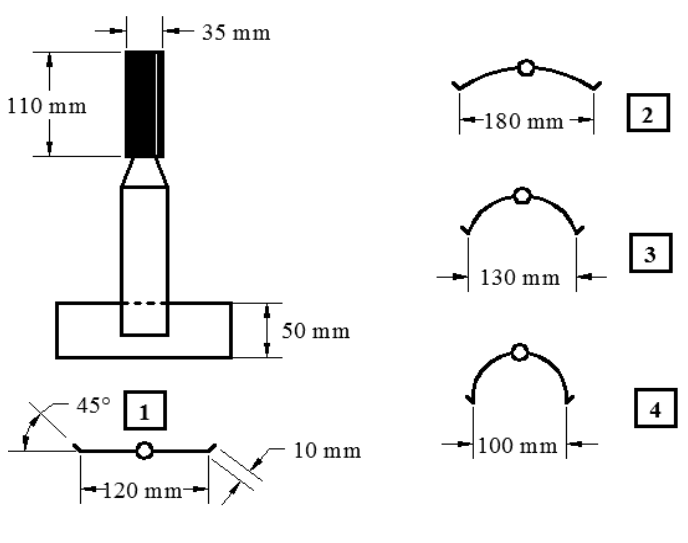
Fig. 4. Tree-ring sampling tools: No 1 – common chisel, No 2, 3, 4 – differently arched chisels (Beinaravi č ius 2005)